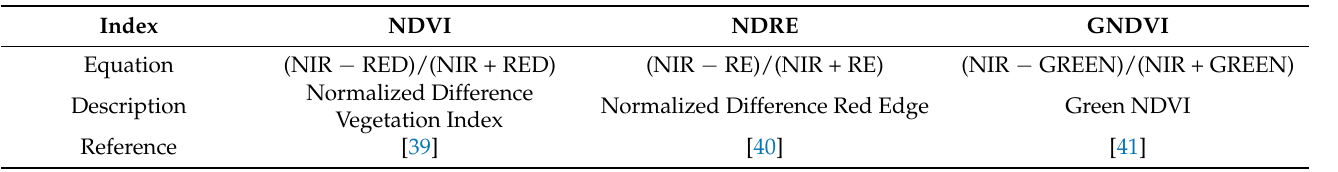
Table 1. Standard formulas used to calculate vegetation indices (VIs) obtained from survey of Miscanthus using unmanned aerial vehicles (UAVs) in the 2018 and 2019 growing season in Urbana, IL, USA.